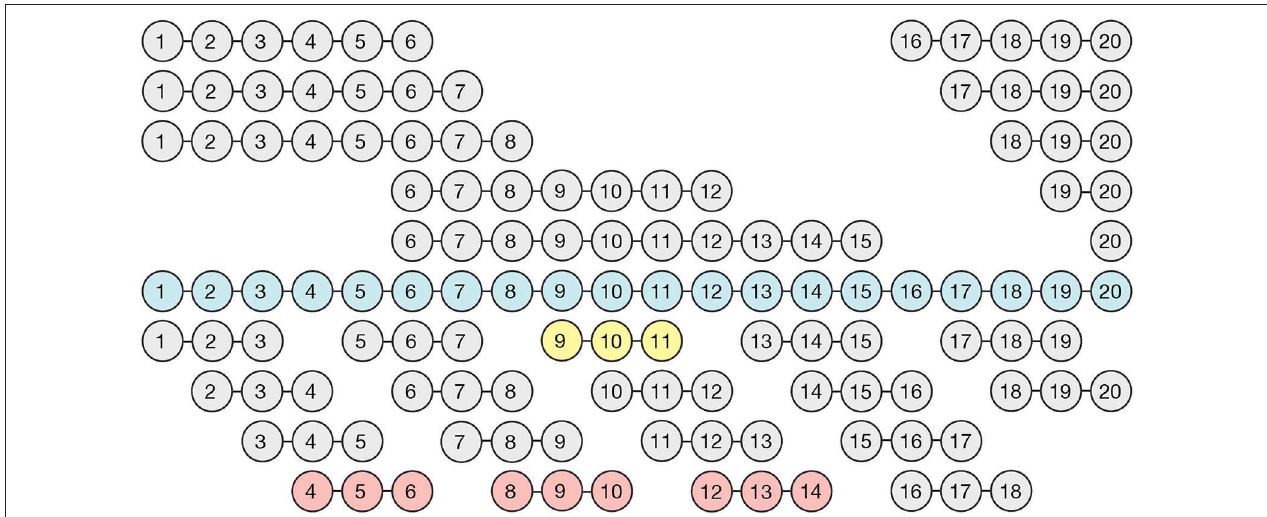
FIGURE 1 | Cloning and expression of fragments spanning the full-length of Factor H. The illustrated recombinant proteins were generated using primers that begin and end in the inter-domain spacers and an expression vector designed specifically to express CCP domains as briefly described in Materials and methods. Full length Factor H (blue), and all of the Factor H sub-fragments depicted above it, were expressed in insect cells, whereas the three-domain fragments depicted below full length Factor H were expressed in the yeast system. Three constructs (shown in red) did not express in the yeast (Pichia) system and one expressed poorly (yellow). Nevertheless, as shown, the entire length was covered so that each domain was expressed in at least twice in the resulting family of proteins.